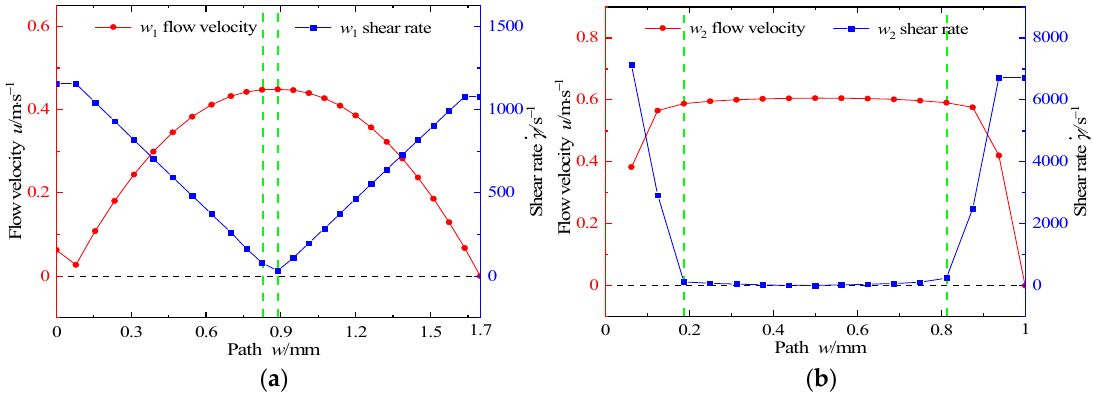
Figure 10. Flow state of MR fluid along the path. ( a ) Path w 1 , ( b ) path w 2 .